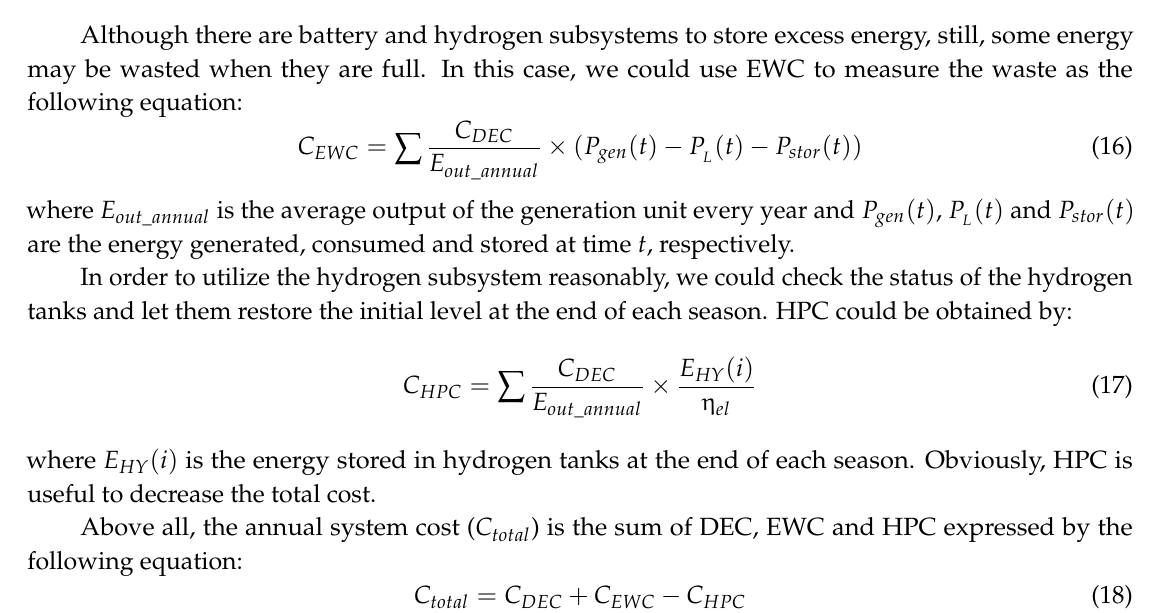
Figure 2. The model of the annual system